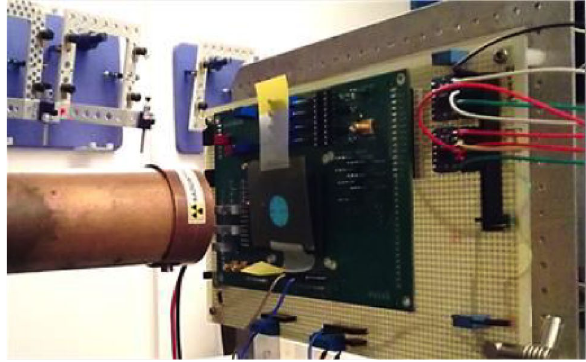
Figure 5. The SPAD test beam setup at LNS Cyclotron.